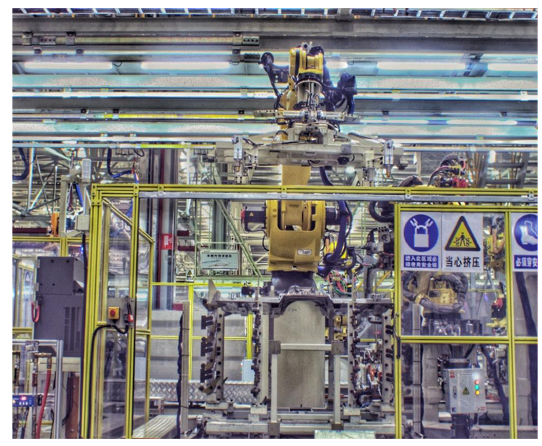
Figure 9. Experimental setup for robot intelligent grasping system. Robot at reset position.